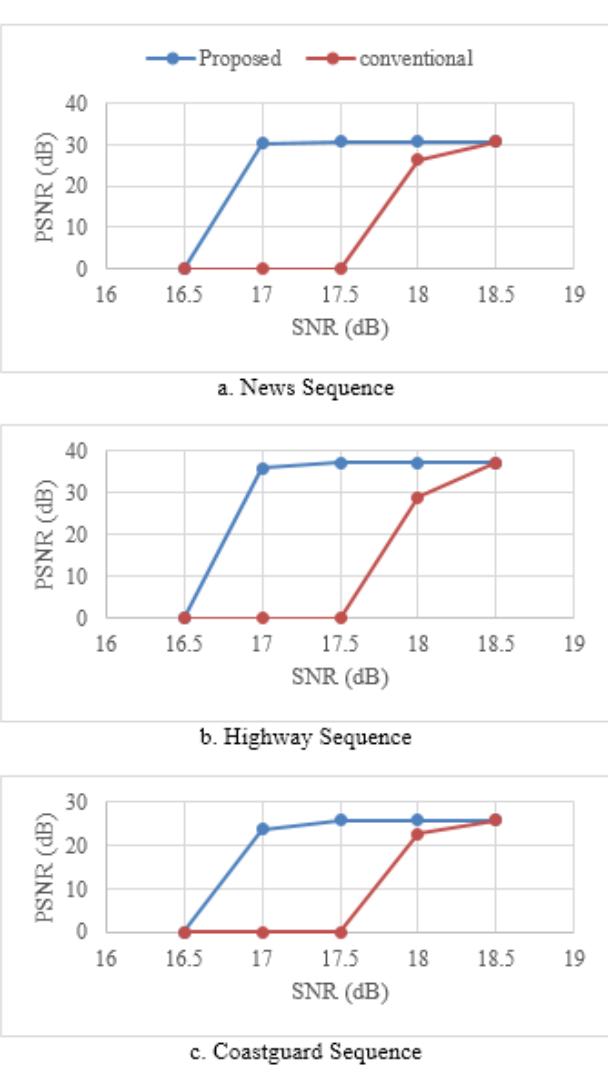
Figure 3. System